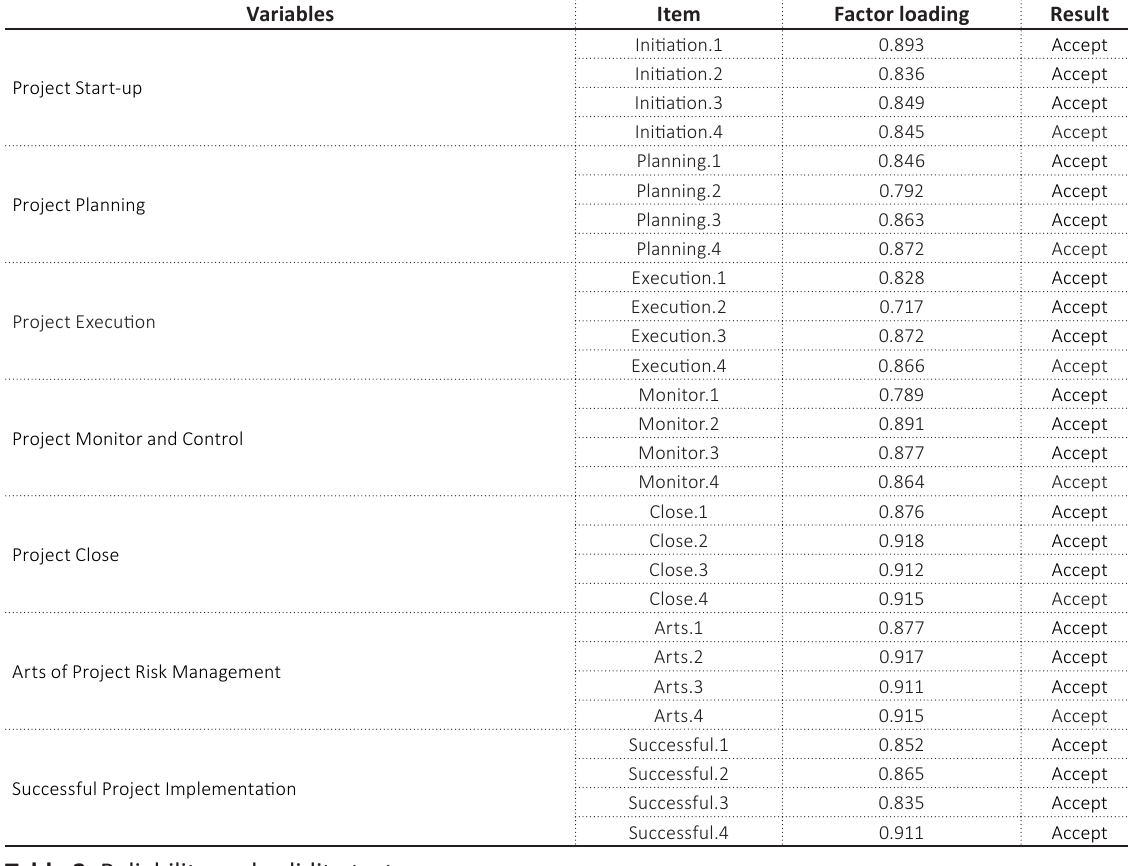
Table 2. Factor loadings of the model